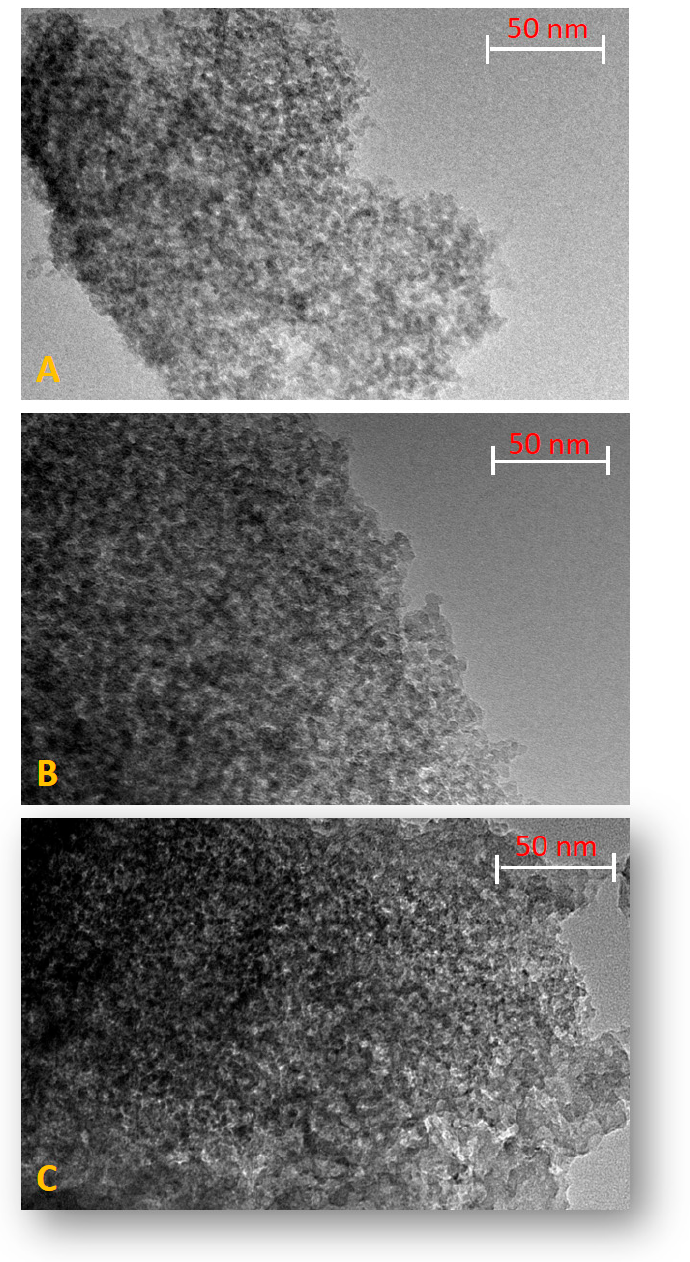
Figure 3. TEM spectra of the silica gel product impregnated with ( A ) NH 4 HSO 4 , ( B ) HCl.Gly, and ( C ) NH 4 Br.